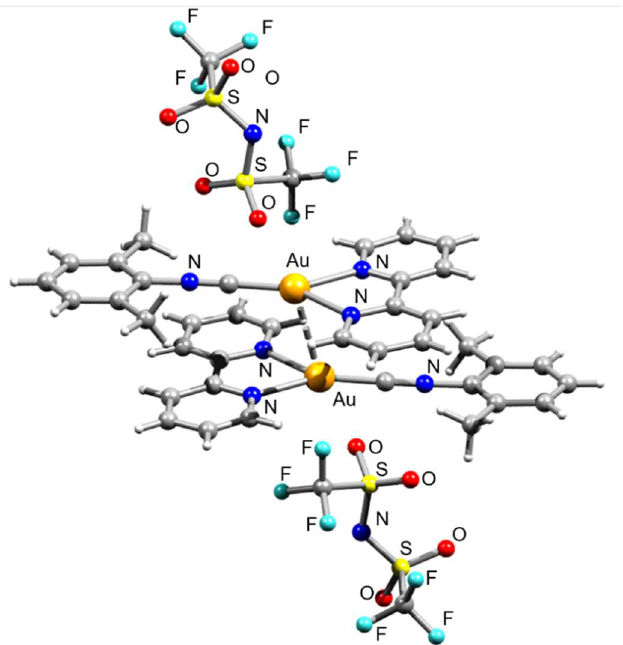
Figure 1. Ball-and-stick representation of the crystal structure of 4 , demonstrating Au · · · Au interac- tion. Grey and light-grey spheres represent carbon and hydrogen atoms, respectively.